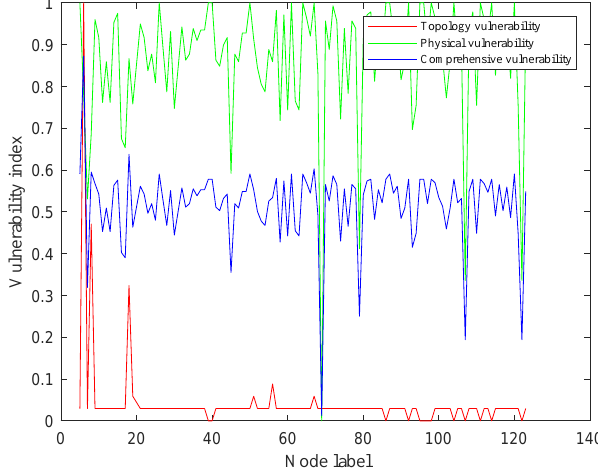
Figure 6. Vulnerability assessment of SF network.